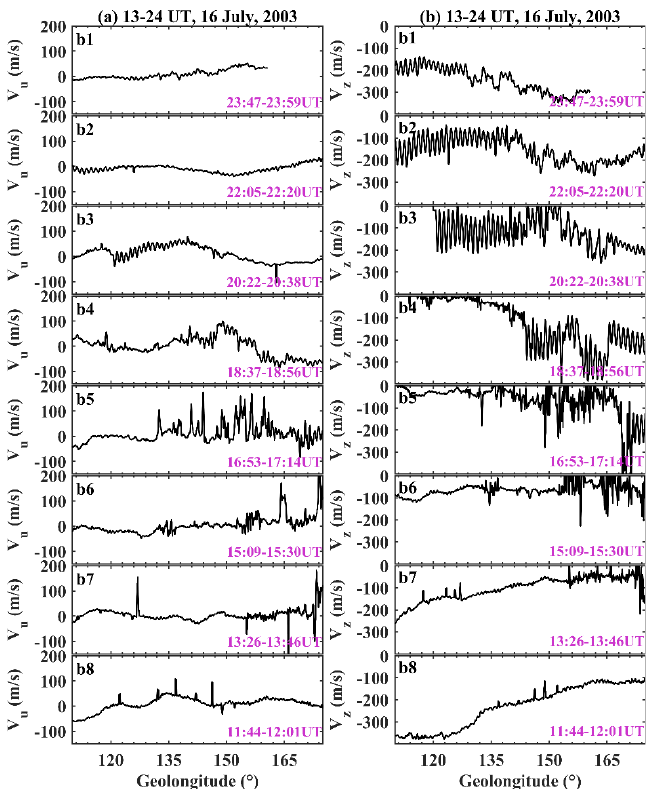
Figure 9. ROCSAT-1 observations of 5-s averaged plasma ( a ) vertical and ( b ) zonal drift variation as a function of geographic longitude over the Eastern Asian sector during 13 – 24 UT on 16 July 2003. The orbits are the same as those used in Figure 7b. Universal time (UT) information is given in the lower right corner of each subfigure. Figure 10 presents the CHAMP descending tracks and the corresponding in situ elec- tron density over Eastern Asia during the period 11 – 15 UT on 15 – 17 July 2003. The tracks are colored differently to indicate the corresponding date. Similar to Figure 7, the red dots represent the geographic locations of the four ionosondes used in this study. Due to the high inclination of CHAMP, the local time of descending tracks has little change during the three days [55], which is approximately at a fixed local time near 2230 LT. We plotted the measured electron density in Figure 10b – g, respectively, following the orbital arrange- ment from west to east in Figure 10a. To be convenient for comparison, we adjusted the position of the corresponding tracks in Figure 10d,e. The date marked with the corre- sponding color is drawn in the bottom right corner of each subfigure. The most prominent feature is the wide and deep plasma depletion that was clearly seen symmetrically at the magnetic equator in Figure 10c,f on 16 July. As shown in Figure 10f, the latitudinal cover- age even reached ~30°N over the two lower latitude ionosondes in Japan. The relatively small latitudinal extension of plasma depletion in Figure 10c reveals the possible reason why plasma depletion was not observed at the crossed longitude on track b7 of ROCAST- 1 in Figure 8b at the same time. At 14 UT (23 JST) on 16 July, the only observation of spread F at OK426 of the four stations in Figure 6 might be associated with the northern edge of plasma depletion on the track of CHAMP in Figure 10c. On 15 and 17 July, we note that